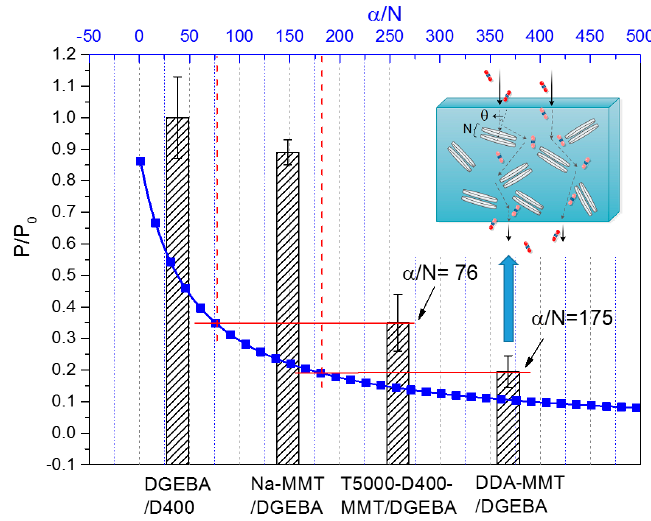
Figure 11. P/P 0 of neat DGEBA/D400 epoxy resin and the corresponding nanocomposites reinforced by Na-MMT, T5000-D400-MMT and DDA-MMT respectively at 3 wt % clay loading. The dotted line shows the prediction curve of P/P 0 as a function of the aspect ratio ( α )/number of layers (N) of fillers, according to the modified Nielsen model. (The density of Na-MMT is 2.66 g·cm − 3 [35] and the density of DGEBA/D400 resin was measured as 1.08 g·cm − 3 .).